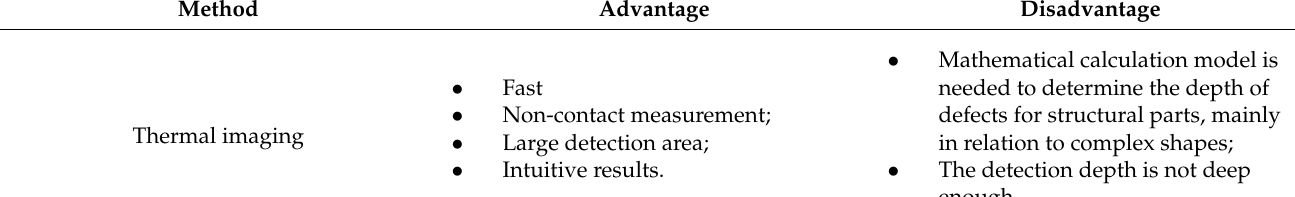
Table 5. Comparison of advantages and disadvantages of the thermography and DIC